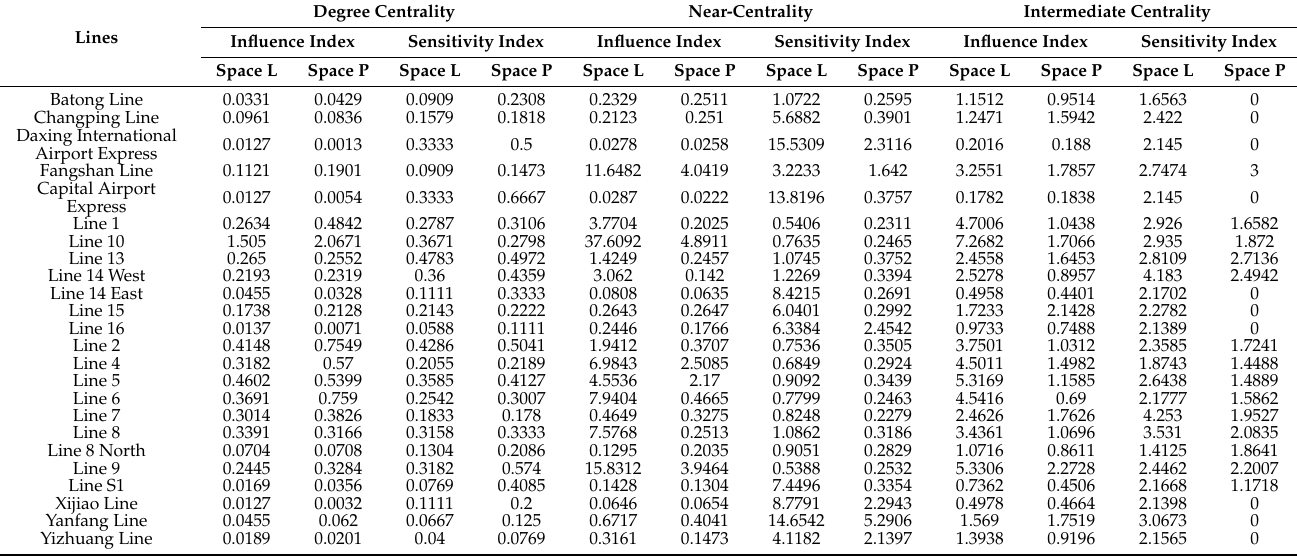
Table 11. Calculation results of interline impact